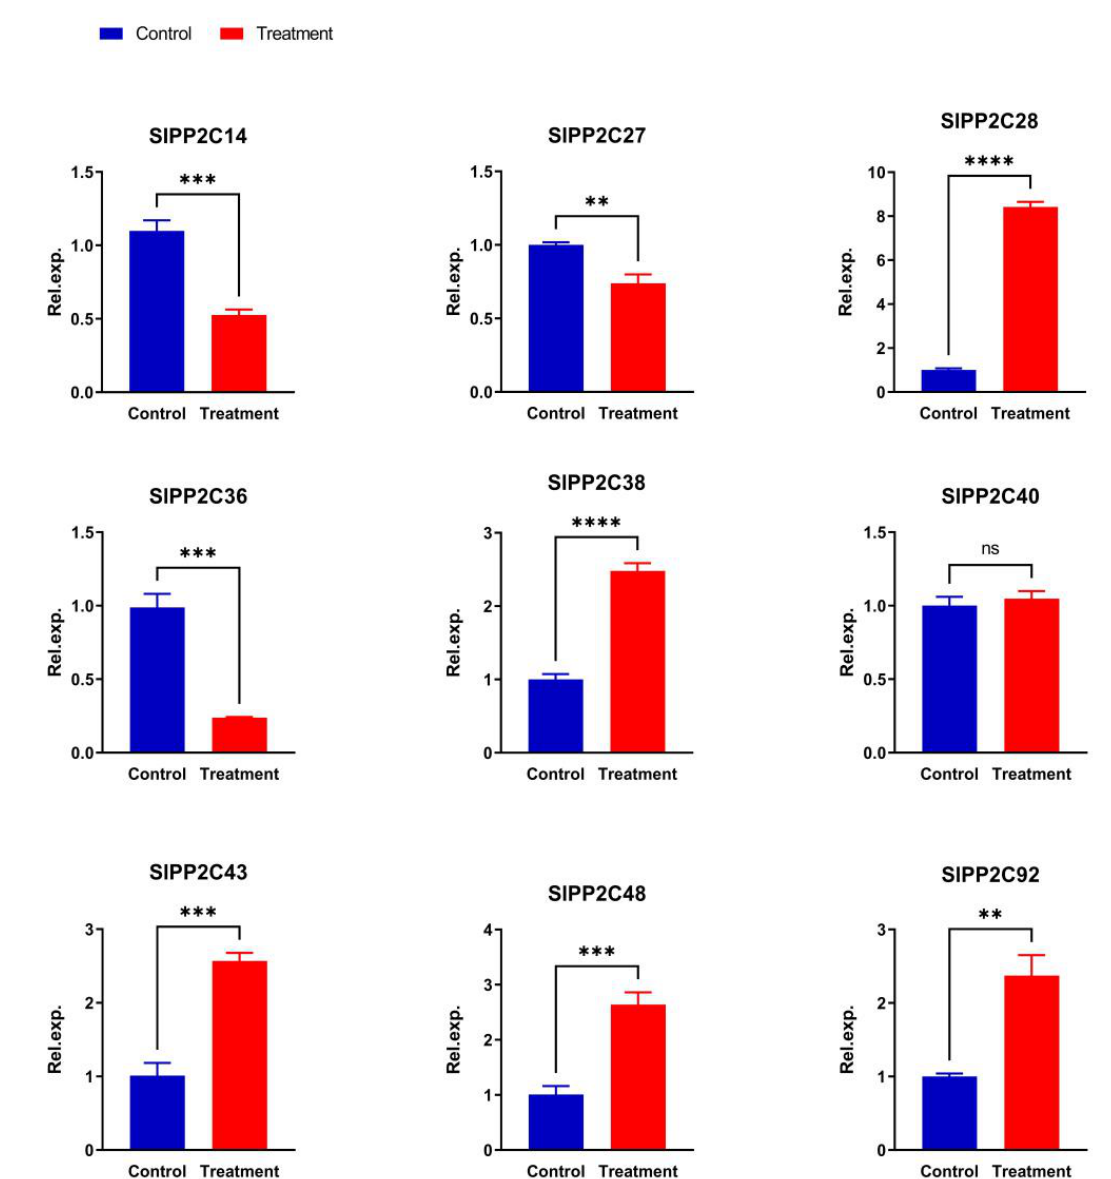
Figure 8. Expression of SlPP2C genes under plant pathogen Ralstonia solanacearum infection treatment. Control means untreated plants playing a controlling role. Treatment is R. solanacearum infection treatment plant. Expression of treated plants was compared with that in untreated plants after normalization of values with reference to the tomato β -actin gene and is presented as the relative expression level. All samples were collected from three biological replicates of each treatment at specified intervals. The error bars represent the SEM. ** p < 0.01, *** p < 0.001, **** p < 0.0001, Ns: not significant. The expression patterns of the selected SlPP2C genes were analyzed by qRT-PCR with gene-specific primers (Supplementary Table S8).